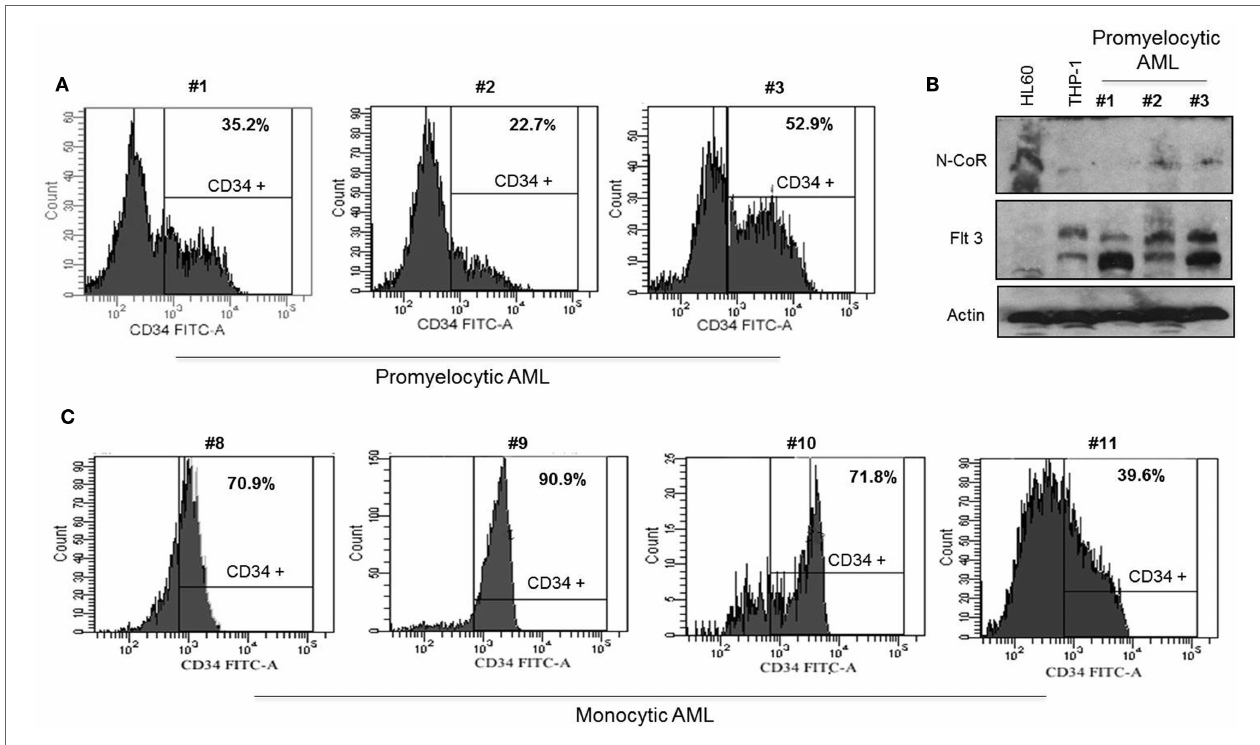
FigUre 5 | Misfolded n-cor is correlated to the cD34 + /Flt3 + -based stem cell phenotype in promyelocytic and monocytic aMl primary patient samples . (a,c) Percentage of CD34 + cells in promyelocytic AML (a) and monocytic AML (c) primary patient samples was determined by flow cytometry. (B) Level of N-CoR and Flt3 proteins in promyelocytic AML primary patient samples used in (a) . HL60 and THP-1 cells were used as positive and negative control for N-CoR protein